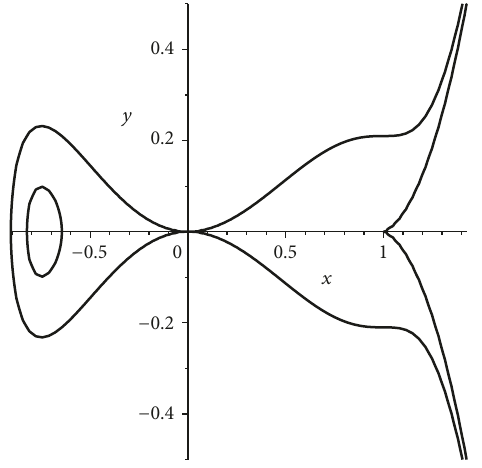
Figure 1: The portrait of system